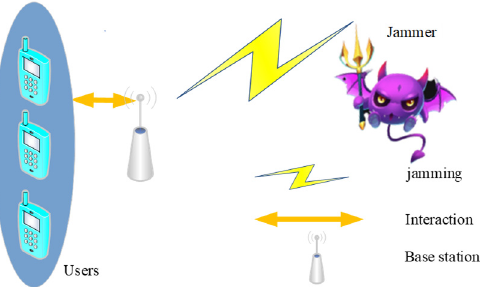
Figure 1. System